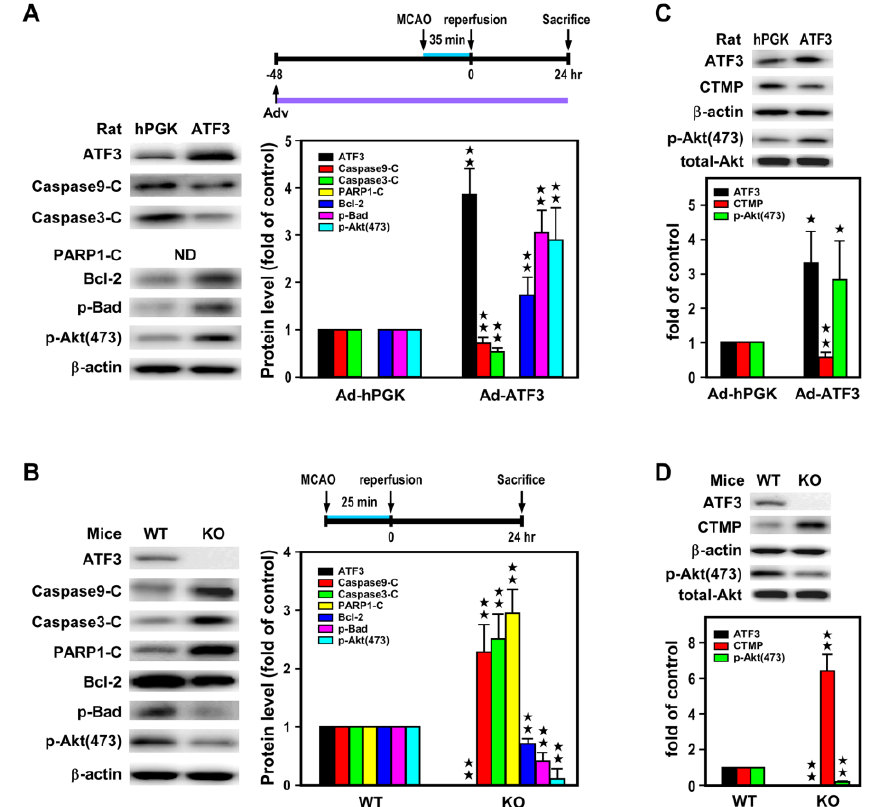
Figure 5. ATF3 overexpression attenuates while knockout aggravates apoptosis in the ischemic brain. Apoptosis-related proteins were measured in ischemic cortices of rats infected with 1 × 10 6 pfu of Ad-ATF3 or Ad-hPGK and subjected to 35 min of MCAO and 24 h of reperfusion ( A , C ). Six rats for each group and each band represents a data point that was extracted from an independent brain sample or in ATF3 KO and WT mice subjected to 25 min of MCAO and 24 h of reperfusion ( B , D ). Six WT or KO mice for each group and each band represents a data point that was extracted from an independent brain sample. Apoptosis-related proteins were analyzed by Western blotting. ND indicates not determined. Bar graphs in the adjacent panels show compiled data. Controls were arbitrarily defined as 1 (Ad-hPGK in panel ( A , C ); or WT in panel ( B , D )). Data are expressed as mean ± SD ( n ≧ 6). ★ p < 0.05 and ★★ p < 0.01 vs. controls. ATF3: activating transcription factor 3; Ad-hPGK: rAd-carrying hPGK promoter; hPGK: human phosphoglycerate kinase; rAd: replication-de- fective recombinant adenoviral; Ad-ATF3: rAd-carrying hPGK promoter-driven ATF3 gene; MCAO: middle cerebral artery occlusion; CTMP: carboxyl-terminal modulator protein.